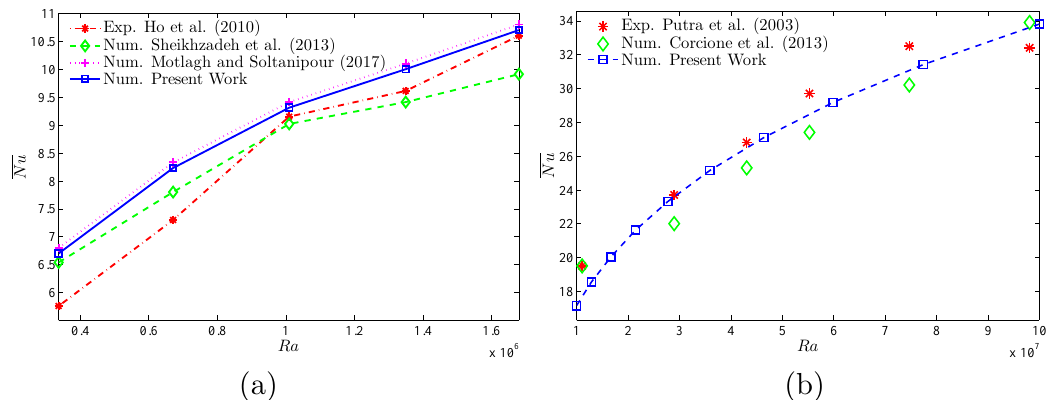
Figure 4. Comparisons of the average Nusselt number of the current numerical work with: ( a ) the experimental outcomes of Ho et al. [43], numerical outcomes of Sheikhzadeh et al. [44], and numerical outcomes of Motlagh and Soltanipour [36] with various Rayleigh numbers for φ = 0.03; and ( b ) the experimental outcomes of Putra et al. [45] and the numerical outcomes of Corcione et al. [41] with various Rayleigh numbers at φ = 0.01, N = 0, and R = 0.